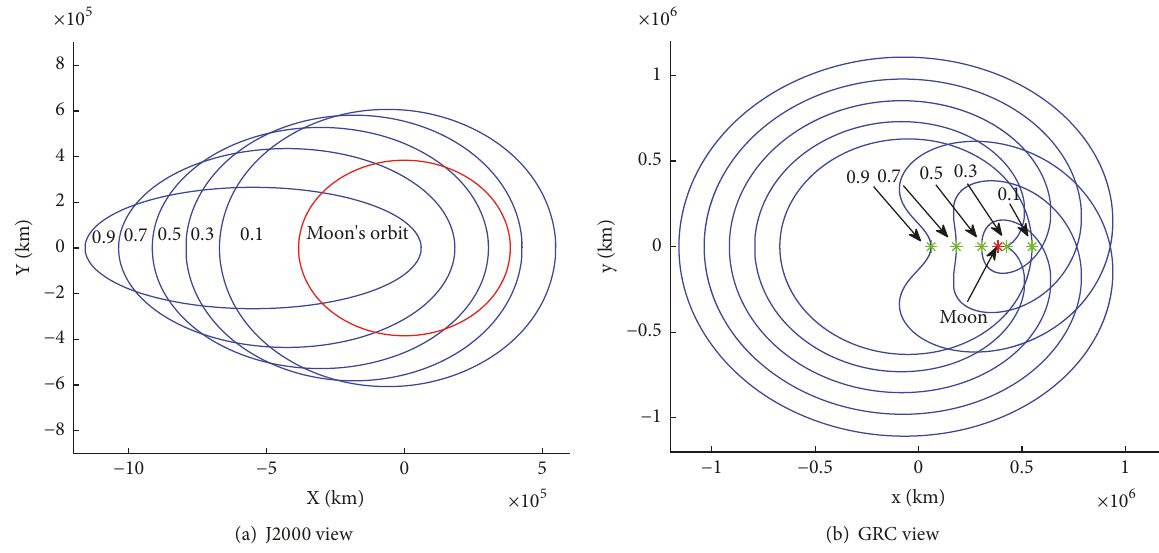
Figure 3: J2000 and GRC views of 1:2 resonant family with different eccentricities.